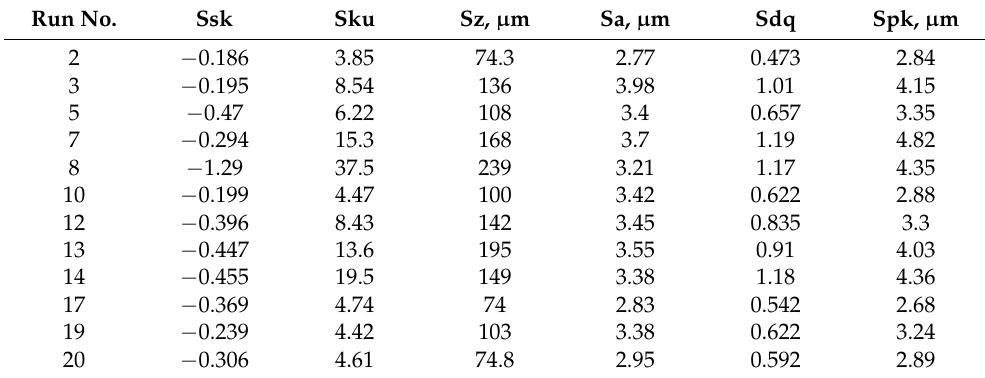
Table 6. Surface roughness parameters measured on the outer surface of the drawpieces. Run